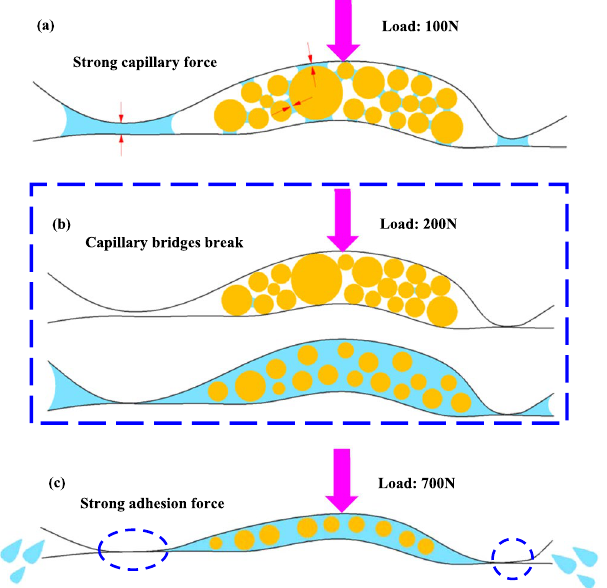
Figure 6. Schematic of the influence mechanism of capillary force and adhesion force in the SiC-SiC friction interface: ( a ) Bulk water does not enter the initial dry friction interface, there is only small amounts of water therein, which forms enormous capillary pressure, causing a strong attraction between asperities, between wear debris, and between asperities and wear debris. ( b ) The increased external load causes the small amounts of water within the three parts to be squeezed out from the capillary bridges to become free water, leading to the equivalent external load suddenly being released, thus resulting in the micro-separation of the interface suddenly increasing, and then generating the passage through which bulk water enters the interface. ( c ) When the load increases to a certain value, exceeding the maximum carrying capacity of the water film, the water in the interface is squeezed out, leading to solid-solid contact area and the contact pressure then increases, thus forming a strong adhesion force between